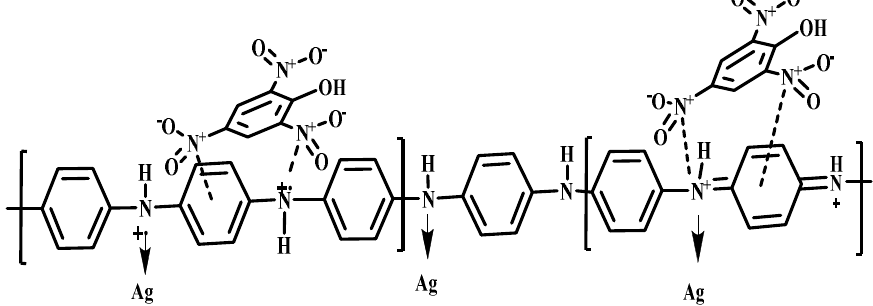
Figure 11. Interaction of TNP with the PANI-Ag composite.